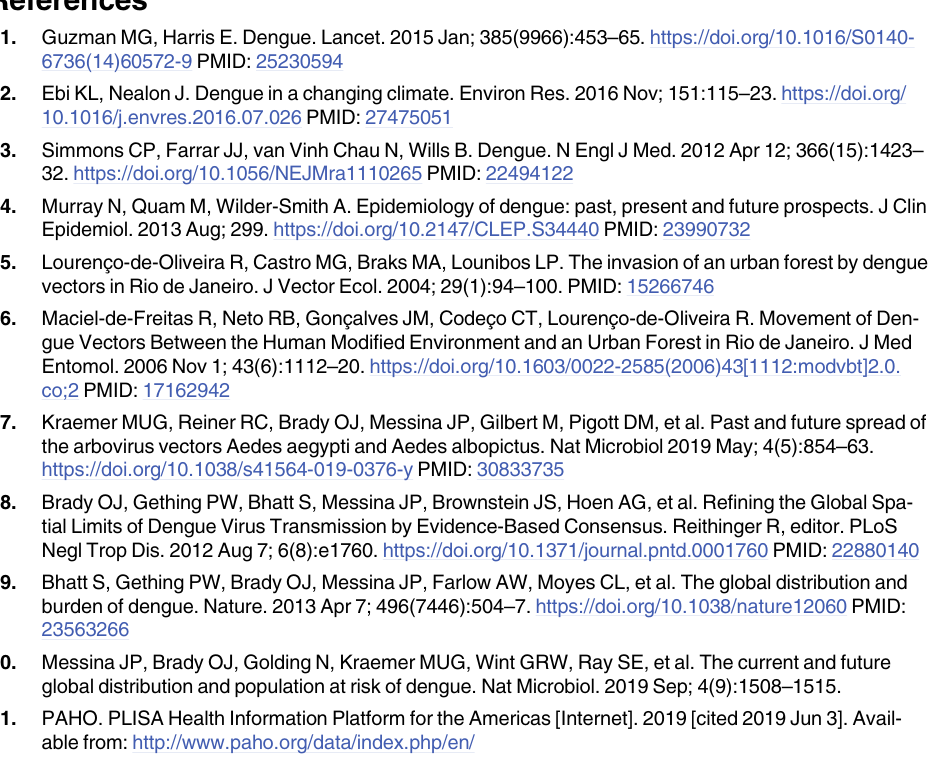
S3 Table. Greatest forest loss compared to mean loss per municipality in Amazonas. S4 Table. Change in dengue incidence 1–5 years after deforestation